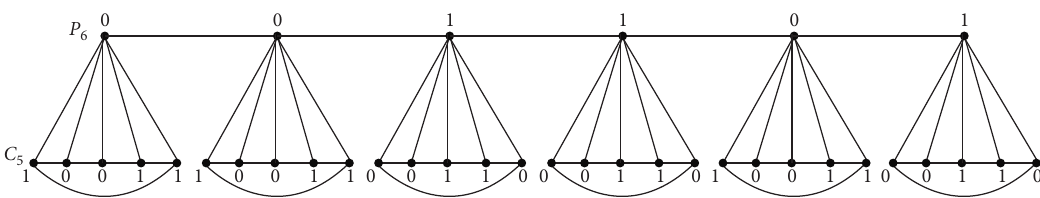
Figure 16: Logical labeling of P